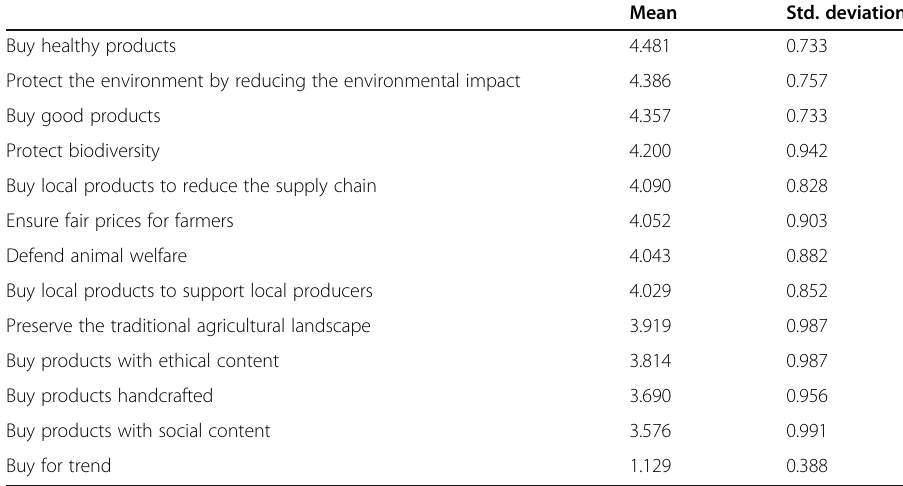
Table 3 Factors considered when buying organic products, with average scores from a 5-point scale (5 indicating strong